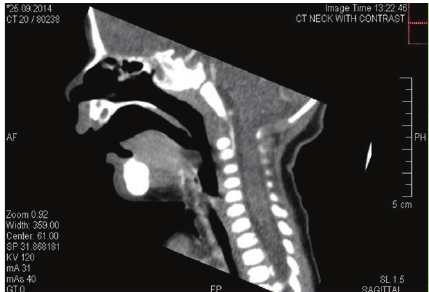
Figure 2: Sagittal CT scan showing a retroglossal fairly defined rounded nonenhancing hypodense cystic lesion measuring about 9 mm, seen projecting into oropharynx.